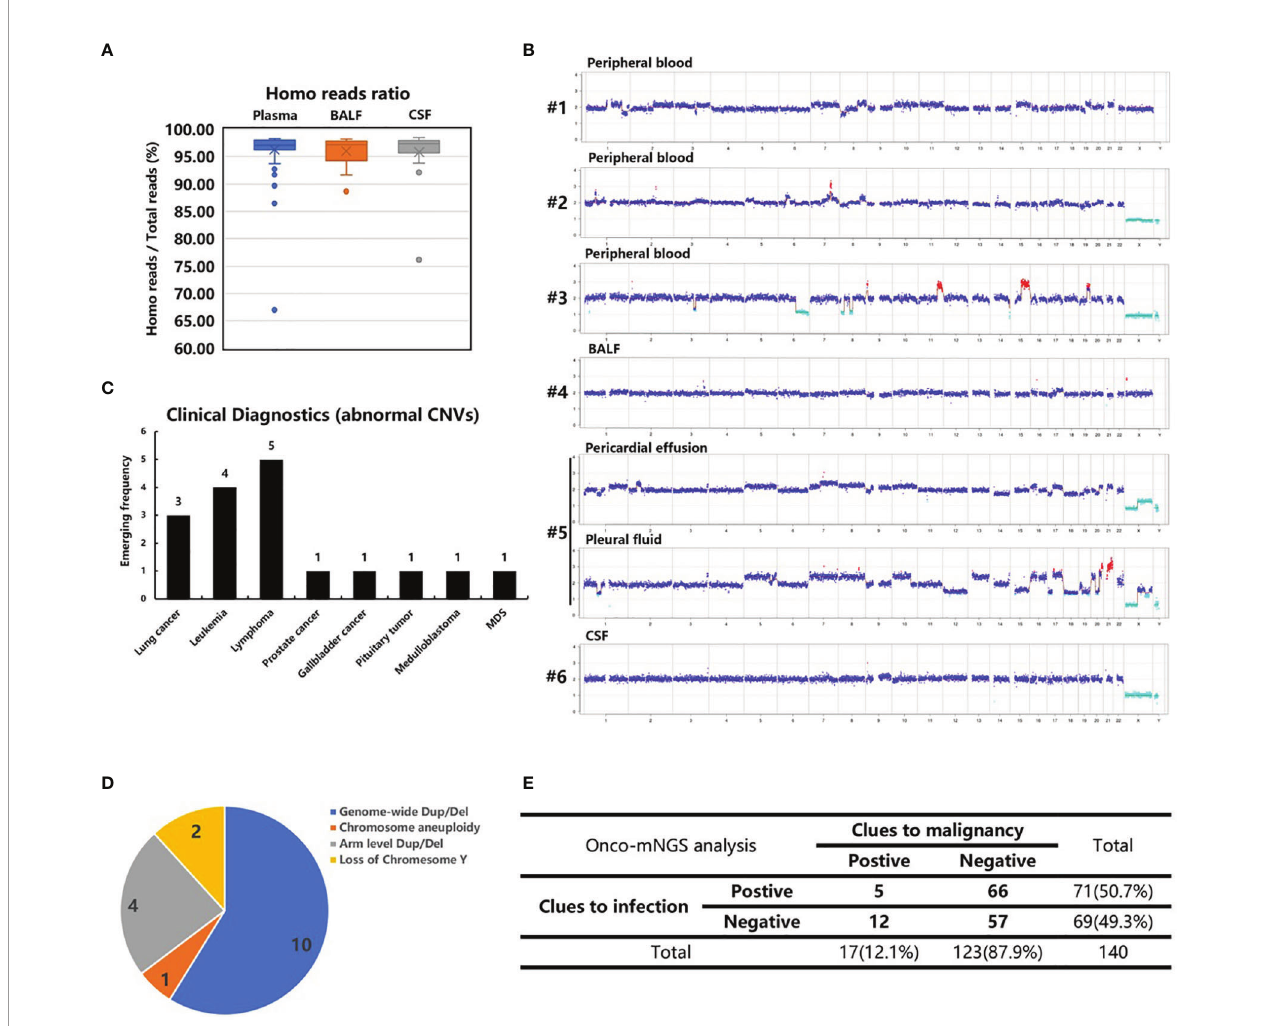
FIGURE 3 | CNV analysis of cancer patients. (A) The homo reads ratios of three sample types (peripheral blood, BALF and CSF). (B) Abnormal CNVs of patients 1- 6 with con fi rmed malignant tumors who were not recognized before CNV analysis. Patient 6, suspected of having central nerve system lymphoma, refused a biopsy. (C) The clinical diagnosis of 17 patients with abnormal CNVs. (D) Classi fi cation of chromosome abnormalities in 17 patients. (E) Summarization of the NGS results of 140 patients with infection and tumor